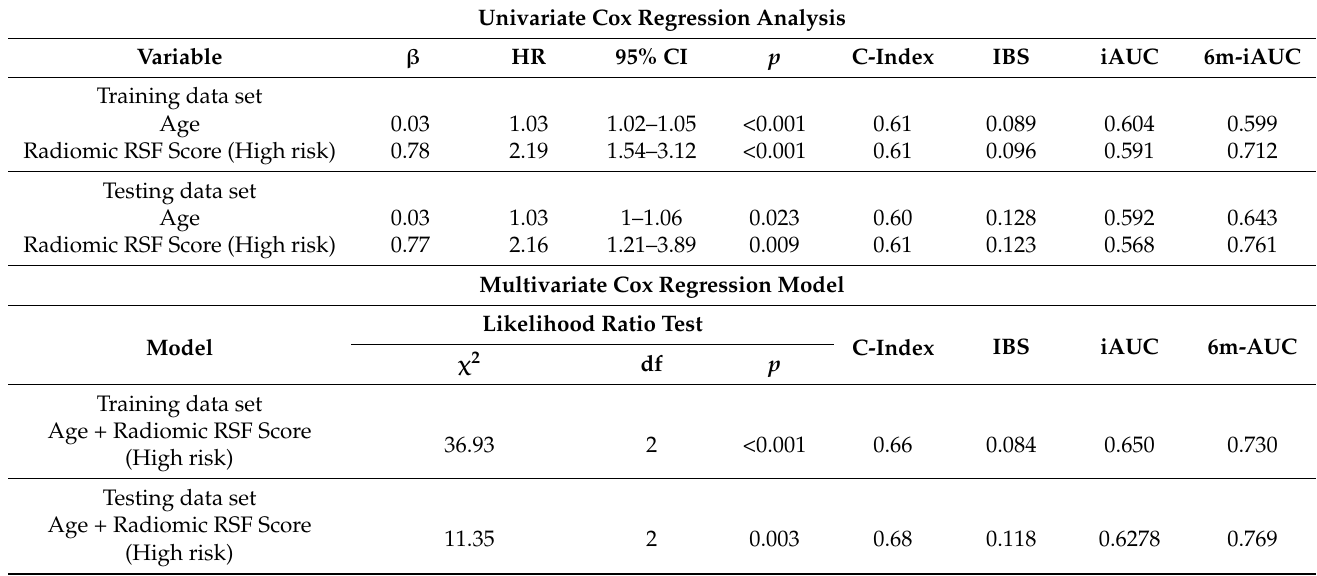
Table 5. Univariate and Multivariate Cox regression